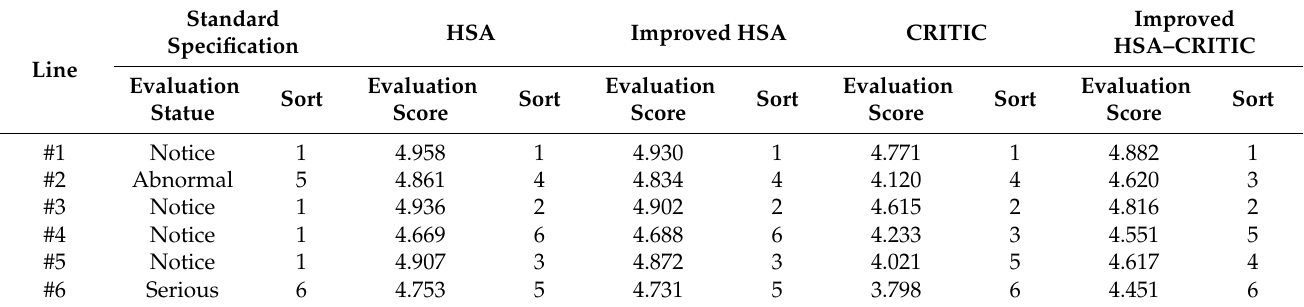
Table 11. Comparison of ETL operation state appraisal